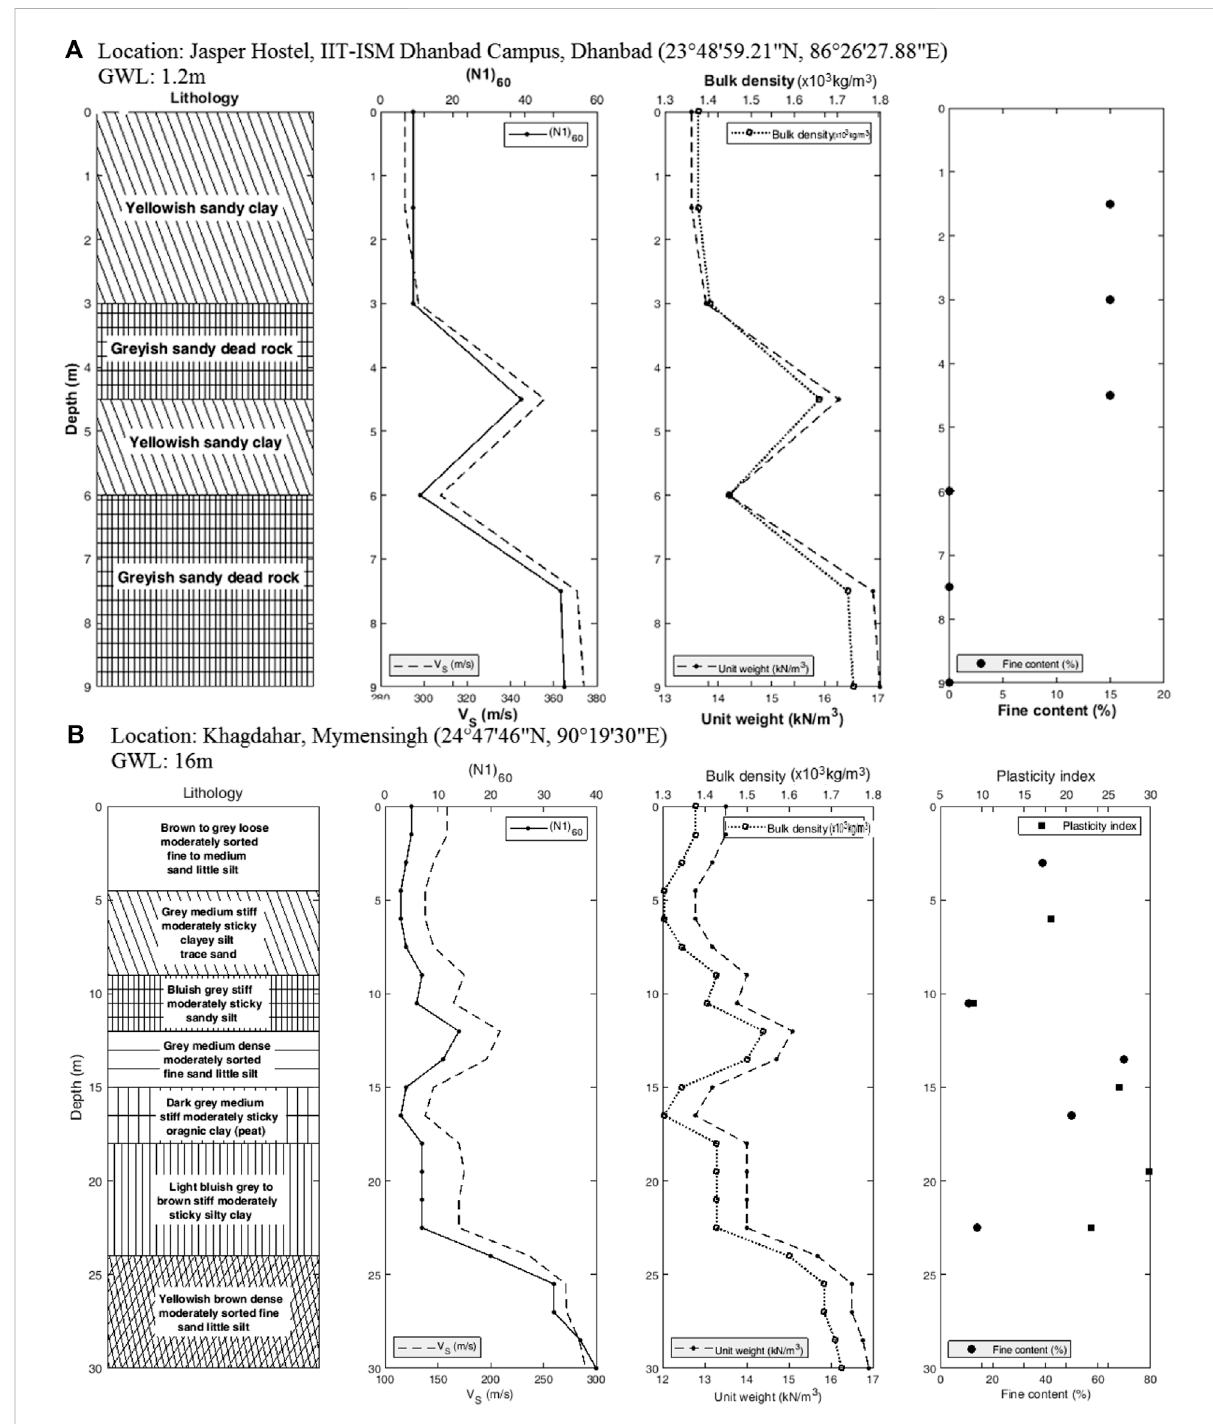
FIGURE 6 Representative depth-wise geotechnical borehole dataset viz. corrected SPT-N, shear wave velocity (m/s), unit weight (kN/m 3 ), bulk density (kg/m 3 ), plasticity index, and fi ne content in percentage for sites in (A) IIT-ISM Dhanbad Campus and (B) Khagdahar,